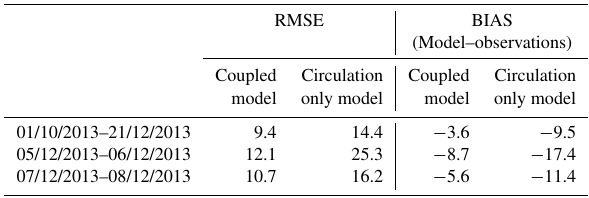
Table 2. Performance of circulation-only and coupled wave- circulation models in reproducing sea level (in centimeters) against observations from 38 tidal gauges in the model area. Their positions are shown in the horizontal map of Fig.